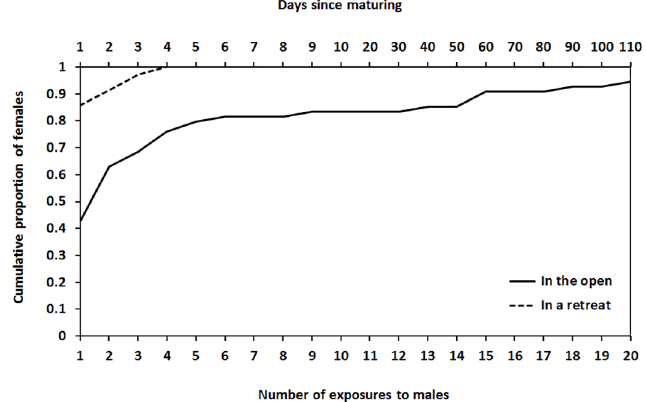
Fig 1. Cumulative proportionof virgin female Servaea incana that mated followingrepeatedexposureto males (a) in the open ( N = 54) or (b) in a retreat ( N = 35).